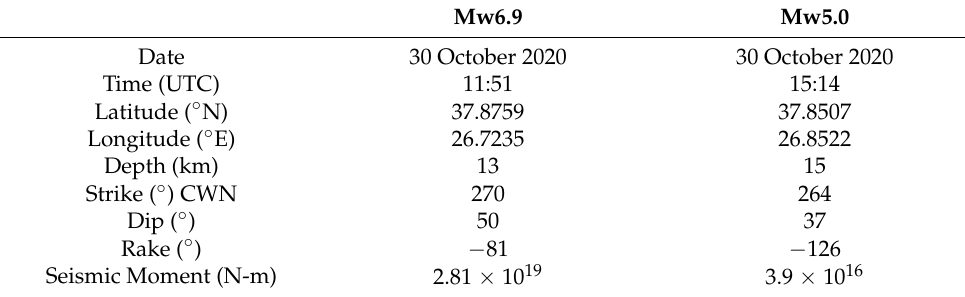
Table 1. Focal mechanism parameters of earthquake and strongest aftershock [25].